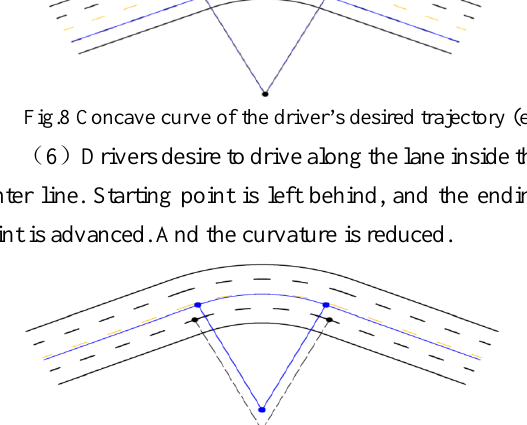
Fig.9 Concave curve of the driver’s desired trajectory (f)